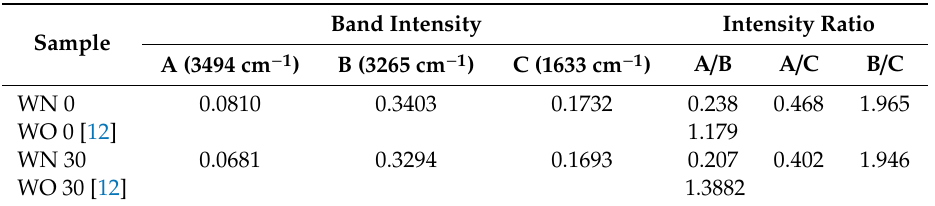
Figure 3. FTIR spectra of spring water from ˙Zywiec Zdr ó j stored in contact with nitrogen prior to (WN0) and after treating with LPGP for 30 min (WN30). Table 1. Intensity of OH stretching (bands A and B) and bending (band C) modes in the FTIR spectra of water taken in the region of 4000–1500 cm − 1